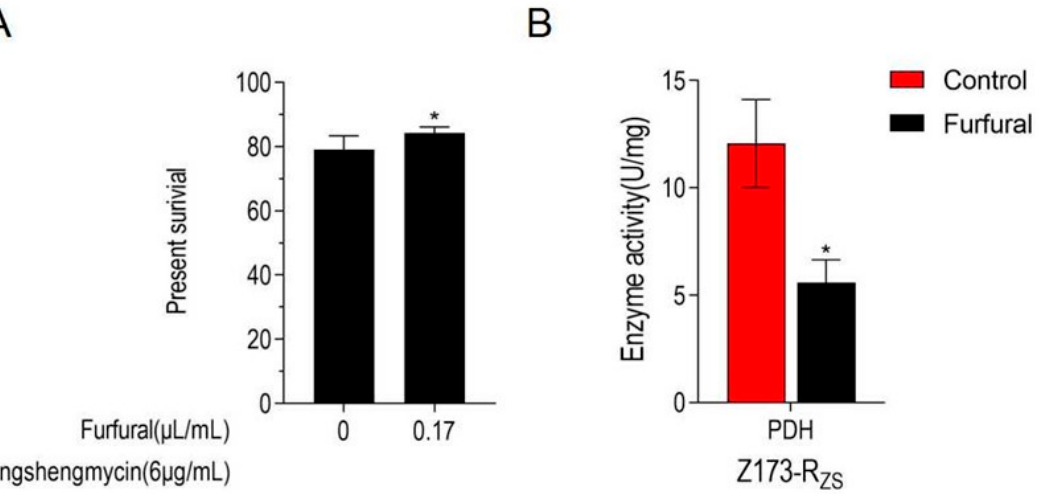
Figure 5. TCA cycle is inhibited in Z173-R ZS . ( A ) Percent survival of Z173-R ZS in the presence or absence of inhibitors furfural or malonate. Z173-R ZS was incubated with ZS (6 μ g/mL) plus furfural (0, 0.17 μ L/mL) in M9 minimal medium, plus NaAc (10.0 mM), MgSO 4 (2.0 mM), and CaCl 2 (0.1 mM) at 30 ° C for 6 h. ( B ) Activities of PDH in Z173-R ZS in the presence or absence of 0.17 μ g/mL furfural. Results are displayed as mean ± SD, and significant differences are identified (* p < 0.05) as determined by Mann-Whitney U Test. At least three biological repeats were carried out.